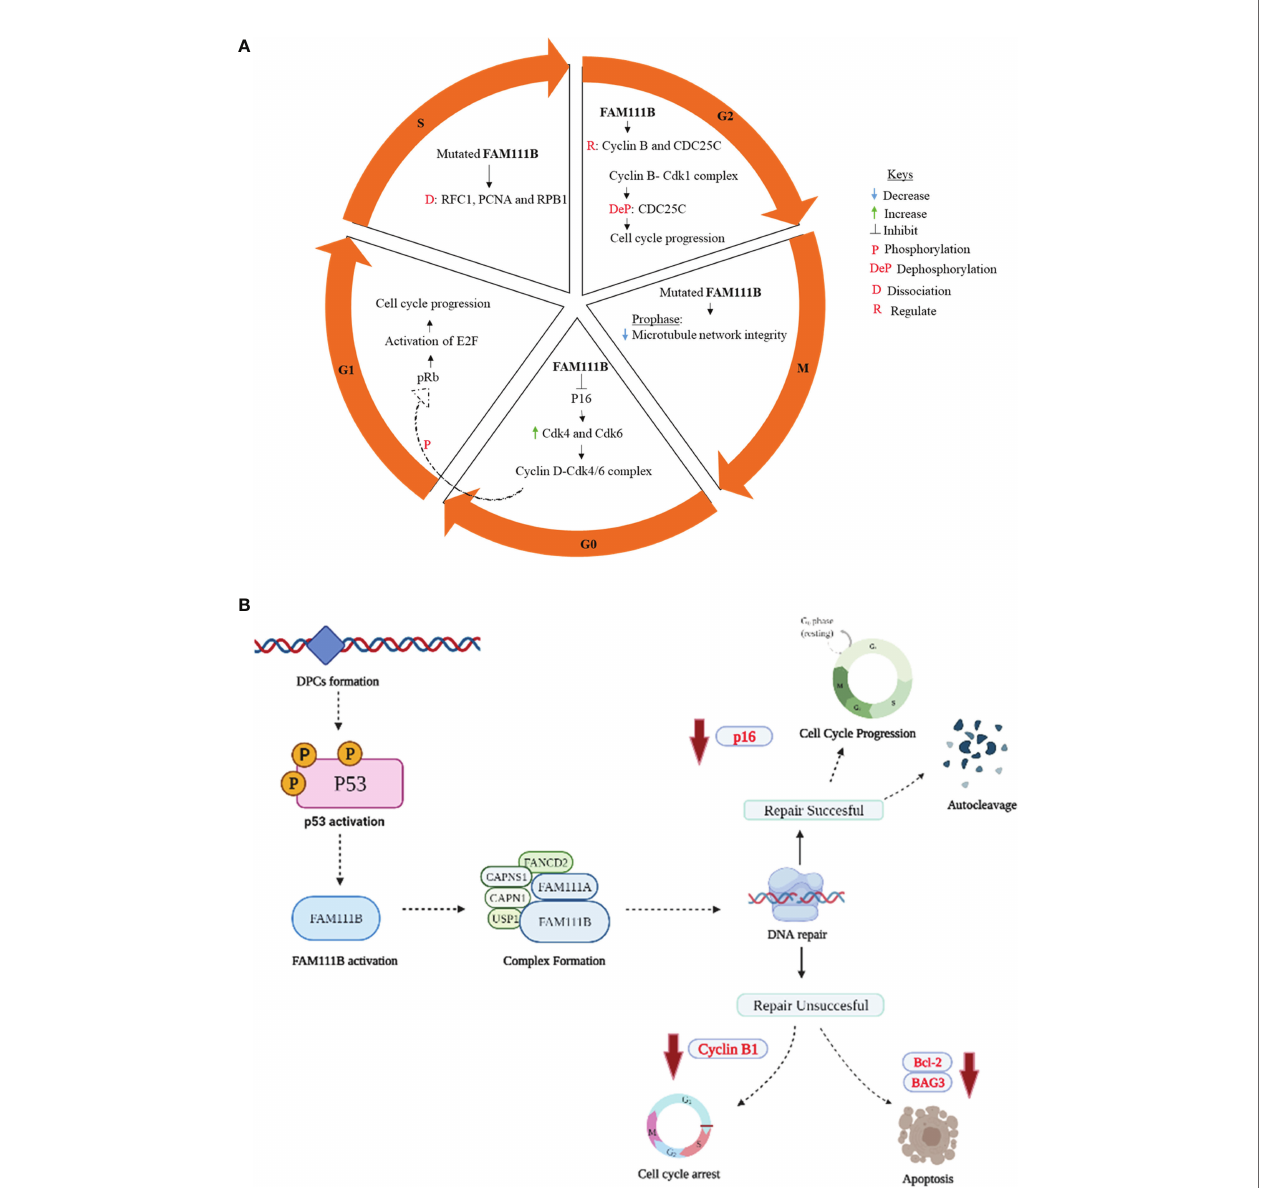
FIGURE 1 | Proposed role of FAM111B in cell cycle regulation, DNA repair, and apoptosis. (A) G 0 /G1 phase: active p16 causes cell cycle arrest by inhibiting cyclin B1 and CDK. When FAM111B is activated, the protease degrades p16, allowing for cell cycle progression. S phase: mutations in FAM111B result in dissociation of RFC1, PCNA, and RPB1, which are involved in the synthesis of DNA. G2/M phase: FAM111B regulates cyclin B and CDC25C, allowing cell cycle progression to the M phase. M phase (prophase)- FAM111B mutations disrupt microtubule network integrity. (B) p53 is activated in response to DNA damage induced by DPCs formation. p53, in turn, directly or indirectly activates downstream signaling proteins, which eventually results in the activation of FAM111B. The active FAM111B, together with other DNA repair proteins such as FAM111A, responds by degrading the DPCs. FAM1111B will restart the cell cycle through p16 downregulation and autocleavage upon successful DNA repair. If the repair is not successful, FAM111B will induce apoptosis by downregulating the anti-apoptotic genes/proteins, e.g., BCL-2 and BAG3 (B created with